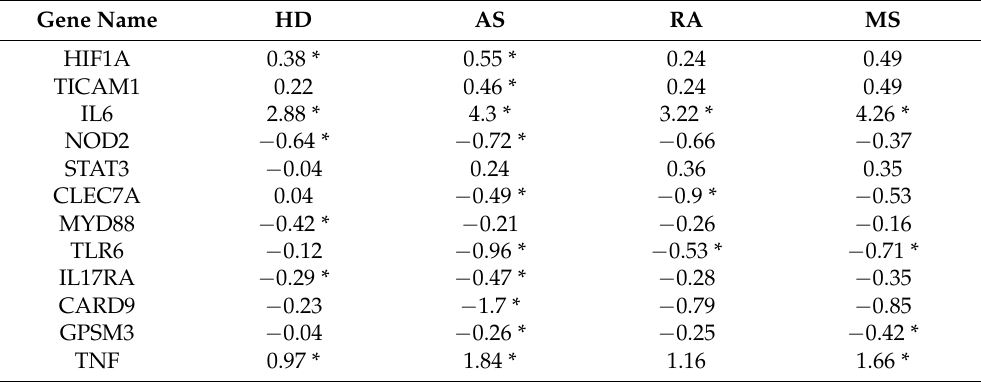
Table 2. The log 2 fold change of 12 genes regulated by stimulation (FDR p < 0.01) associated with the positive regulation of cytokine production involved in inflammatory response (GO:1900017). The treatment-induced alterations in transcripts abundance levels in each disease group are